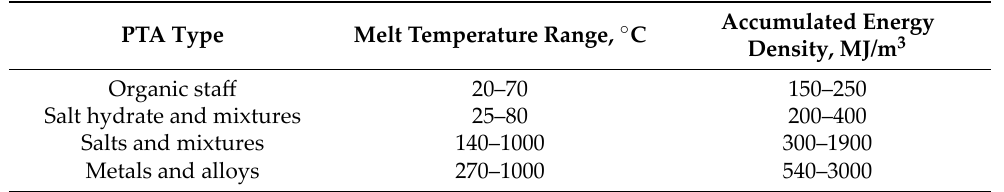
Table 2. Materials for phase transition accumulators.